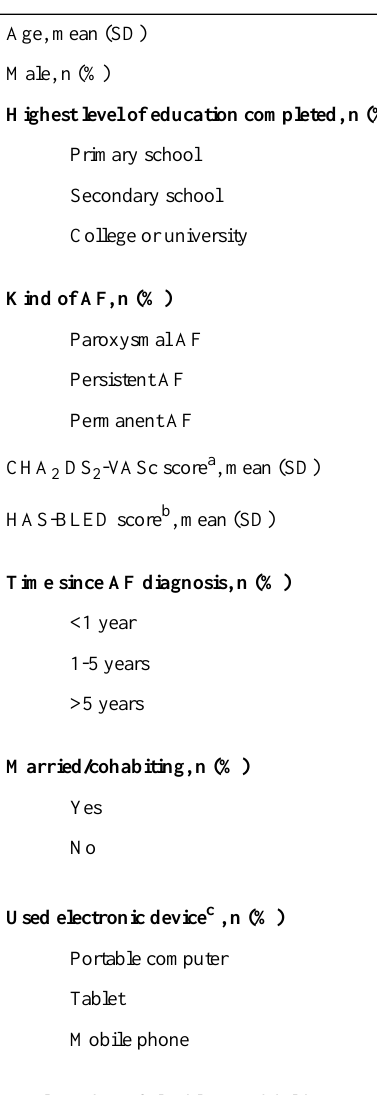
All AF patients